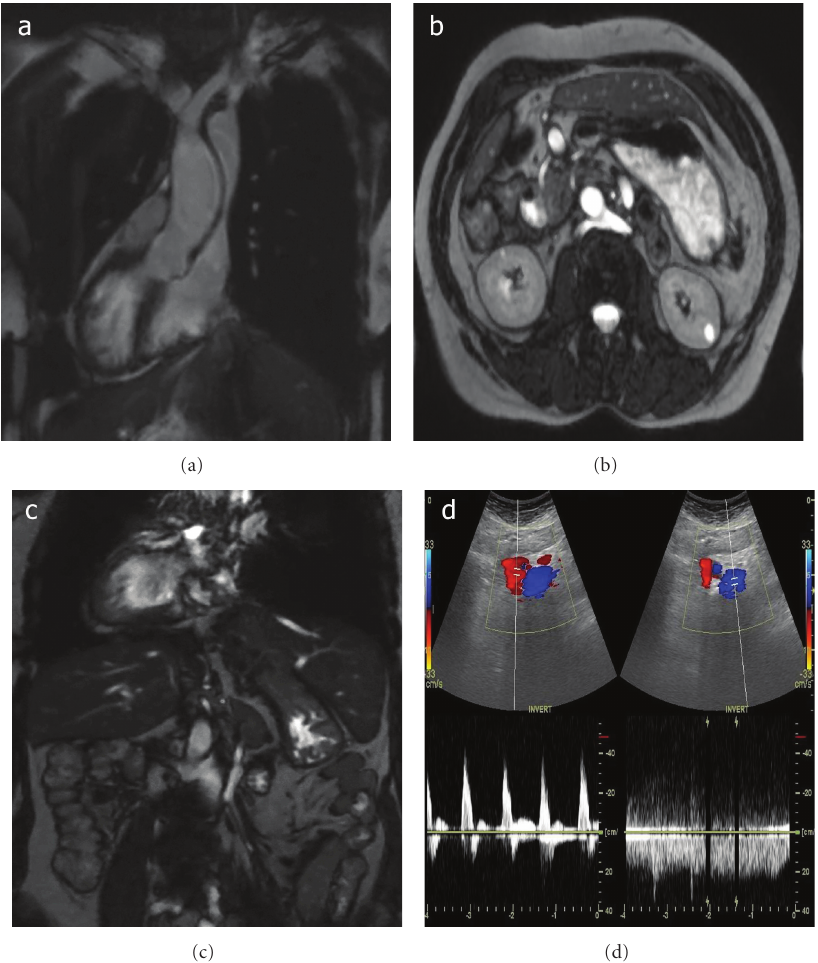
Figure 1: BTFE-BH SENSE sequence on MRI and CDUS. (a) On coronal MRI, right-sided apex of the heart (dextrocardia), aorta in the middle, the pulmonary artery at the right of the aorta, and the superior vena cava at the left of the aorta are observed. (b) and (c) Axial and coronal MRI images show right-sided aorta, left-sided inferior vena cava, and retroaortic right renal vein. (d) In CDUS, current and spectrum images for the aorta at the right-hand side and the inferior vena cava at the left-hand side are